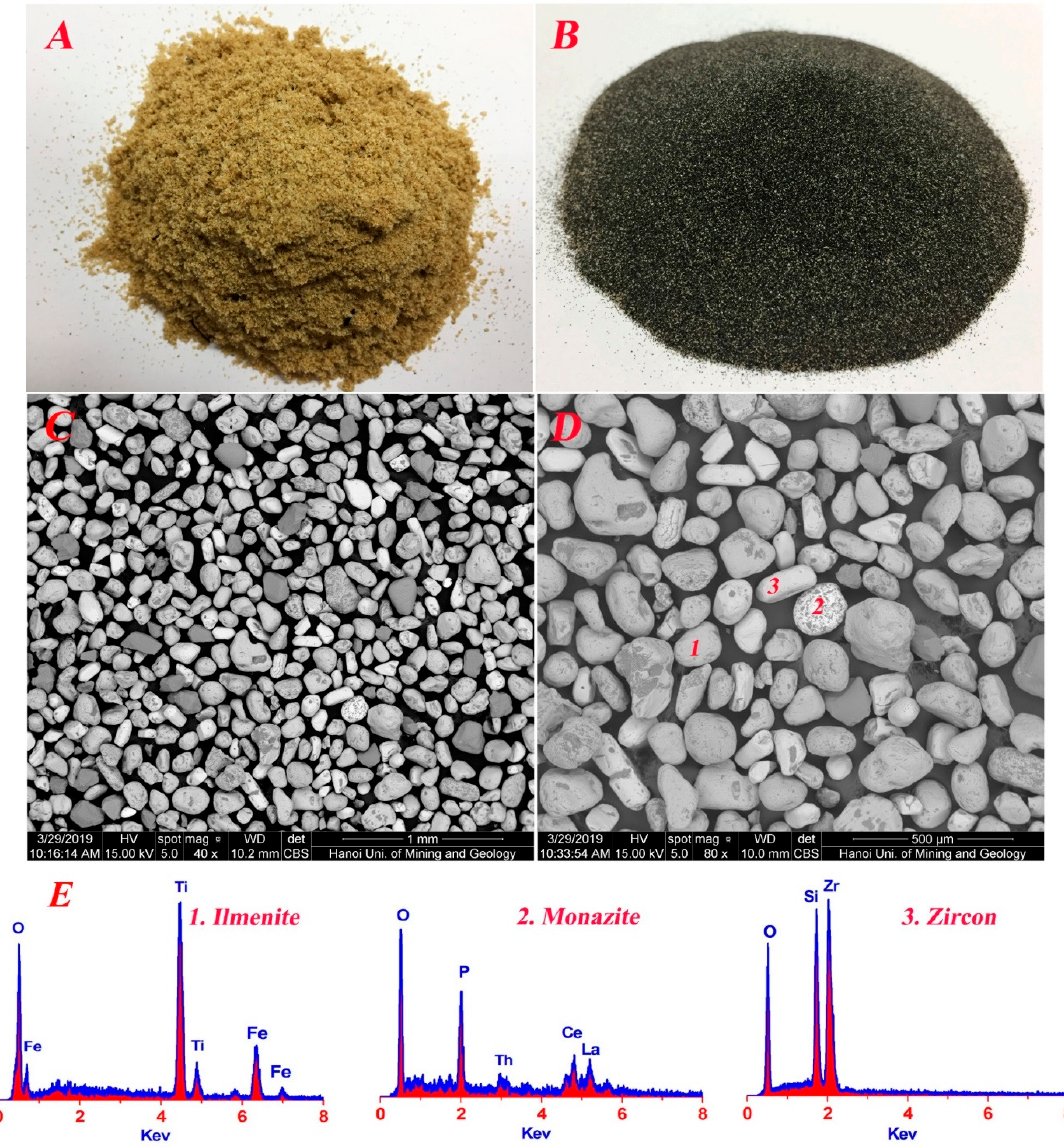
Figure 5. Images of the placer sand in the study area. ( A ) Placer sand, ( B ) placer ore, ( C,D ) SEM images of placer ore, ( E ) EDS results of minerals.